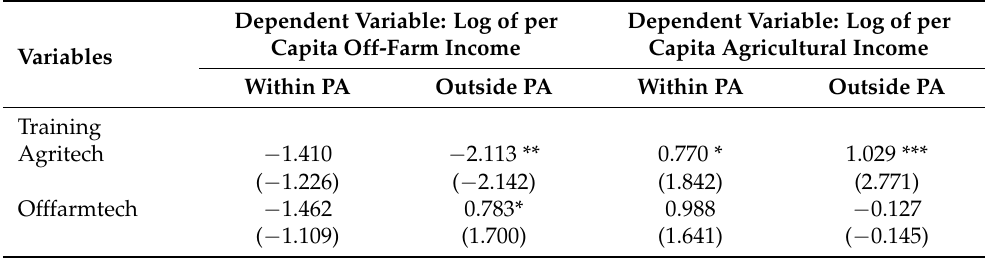
Table 6. The impacts of two different types of skill training on household off-farm and agricultural income within and outside